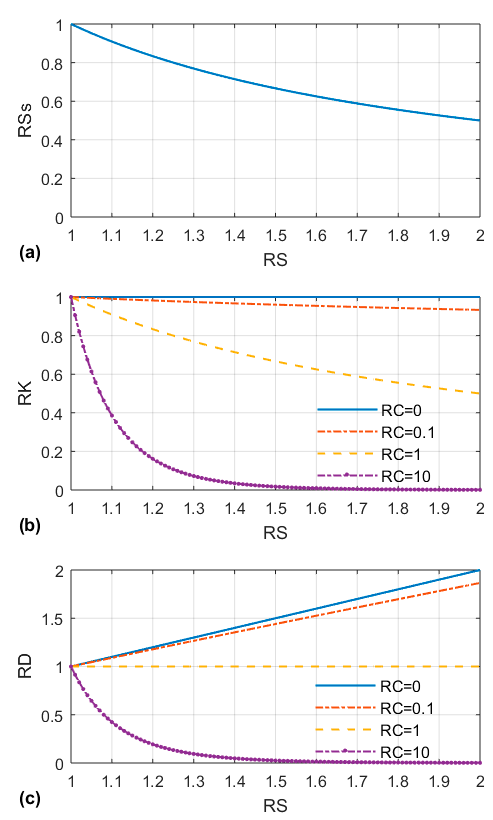
Figure 1. Relations of dimensionless RSs = S s / S s 0 ( a ), Rk = K / K 0 ( b ), and RD = D / D 0 ( c ) against normalized e ff ective stress RS = σ (cid:48) v / σ (cid:48) with four di ff erent values of RC = C / C k ( = 0, 0.1, 1, and 10). v 0